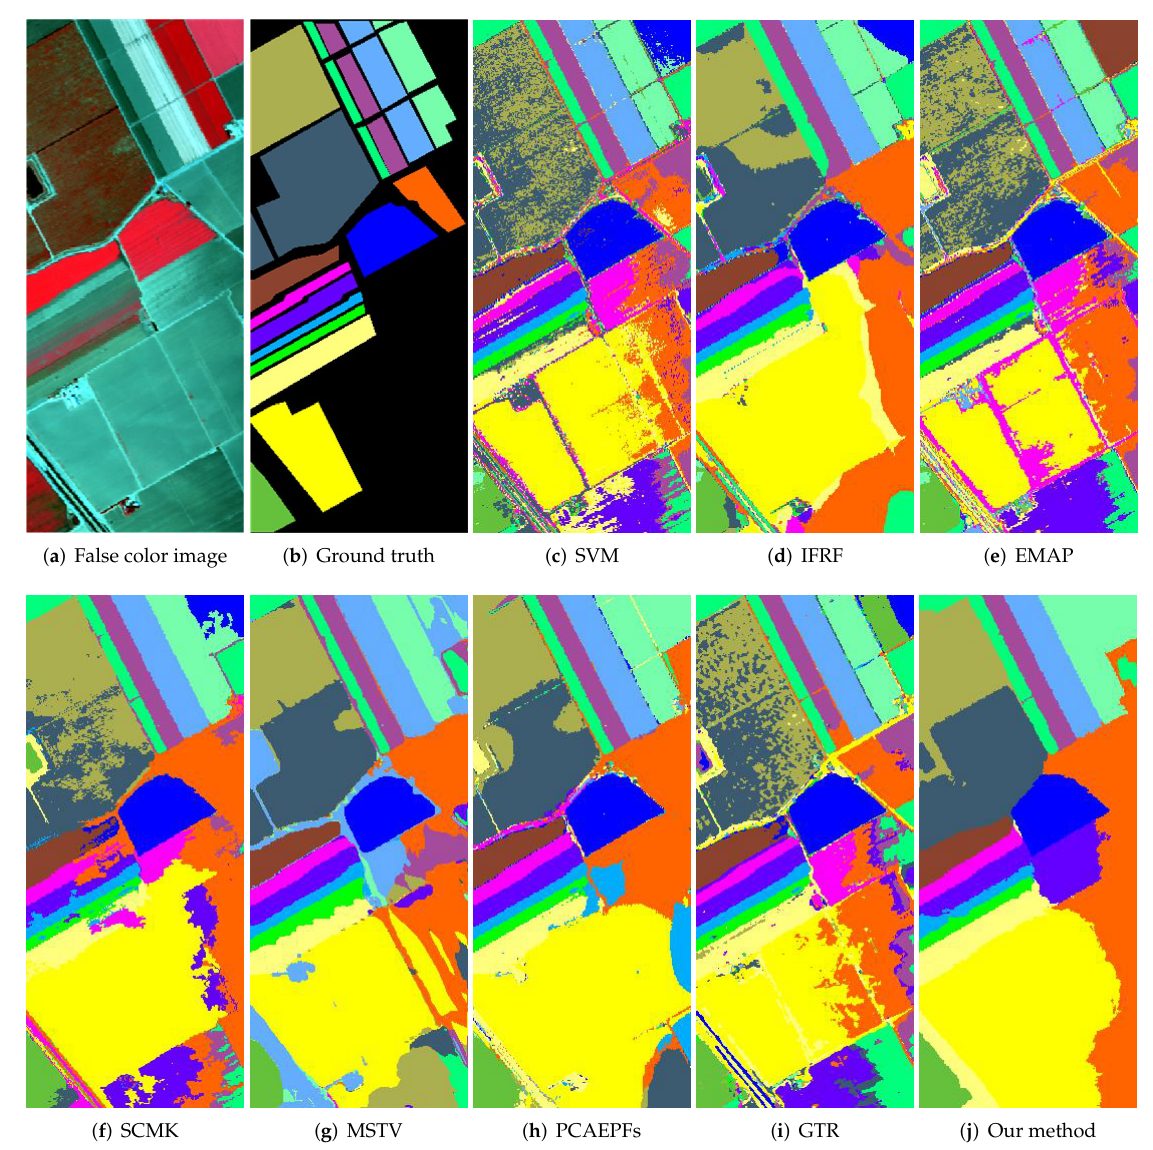
Figure 7. Classification results of all considered approaches on Salinas dataset. ( a ) False color im- age. ( b ) Ground truth. ( c ) SVM [33], OA = 80.08%. ( d ) IFRF [14], OA = 90.67%. ( e ) EMAP [13], OA = 85.54%. ( f ) SCMK [39], OA = 88.70%. ( g ) MSTV [15], OA = 94.46%. ( h ) PCAEPFs [8], OA = 95.12%. ( i ) GTR [40], OA = 85.59%. ( j ) Our method, OA =